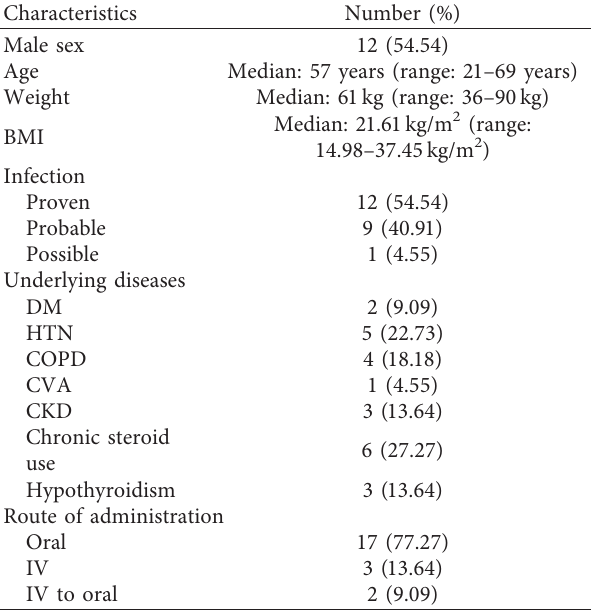
Table 1: Patients’ demographic characteristics and clinical data. Characteristics